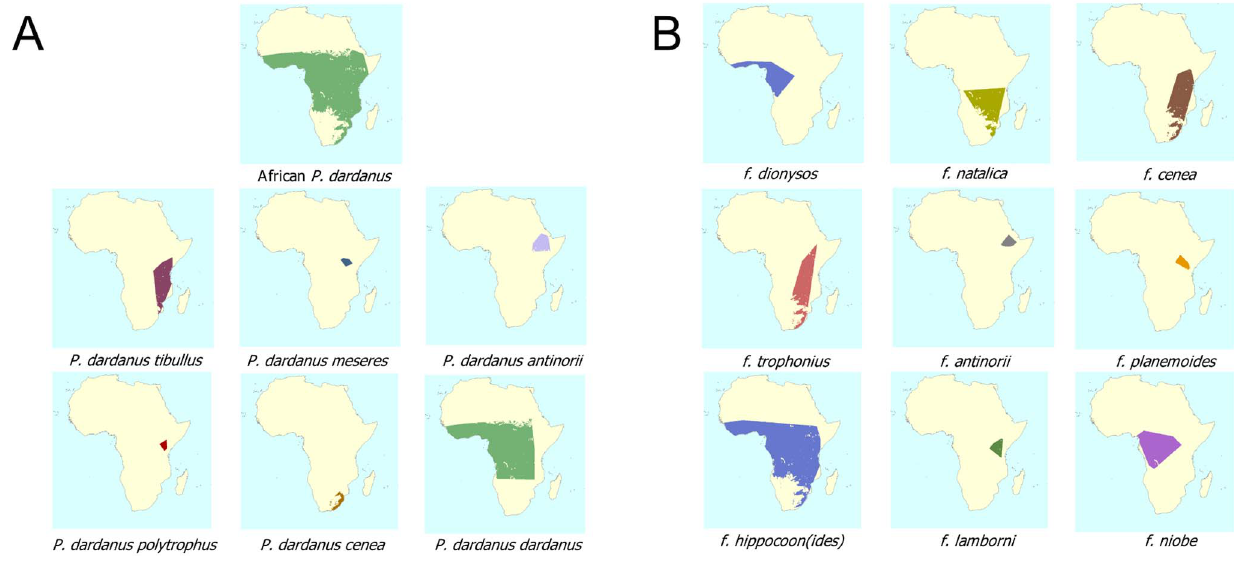
Figure 6. Distribution maps. A) Distribution maps showing the inferred range for the entirety of P. dardanus and the various described subspecies. B) Distribution maps showing inferred ranges of the morph groups of female wing patterns in P. dardanus . Substantial variation in the extents of subspecies ranges is present, and there is little correspondence between the subspecies ranges (A) and the morph ranges (B).